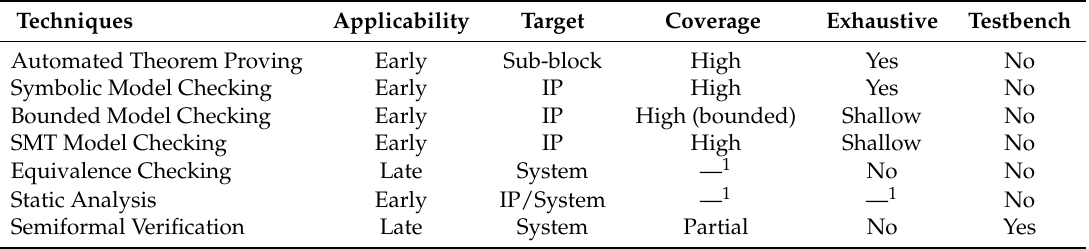
Table 2. Comparison of all techniques for different aspects of the development